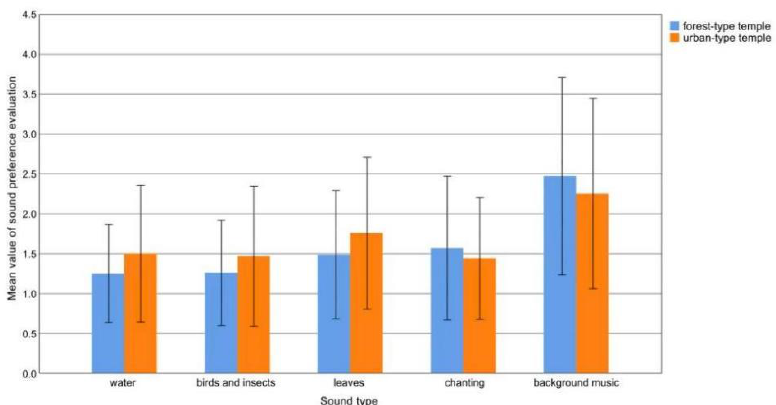
Figure 10. The evaluation value and standard deviation of sound preference for the five sounds with significant differences between the two types of temples.